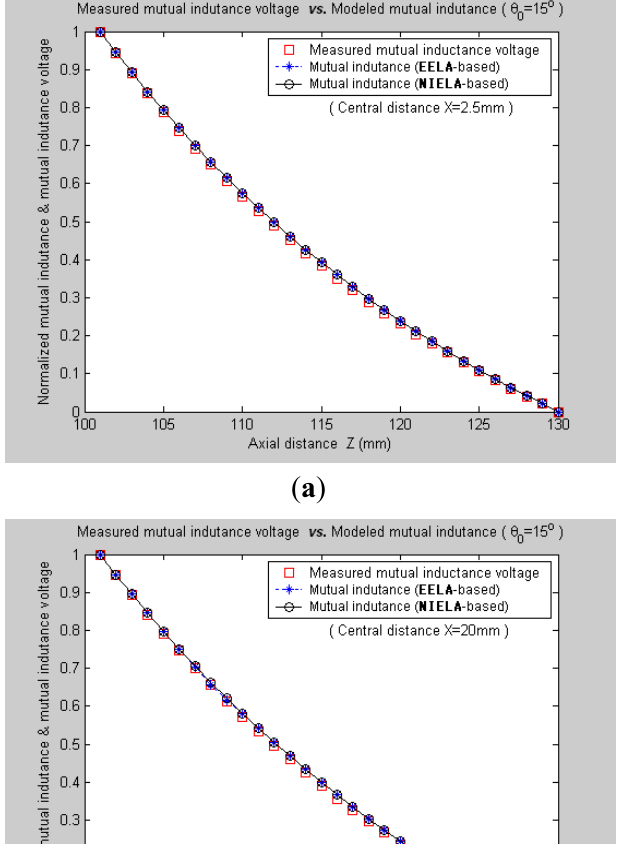
Figure 12. Normalized curves for measured mutual inductance voltage, NIELA -based mutual inductance and EELA -based mutual inductance when θ ( b ) X = 20 mm; ( c ) X = 35